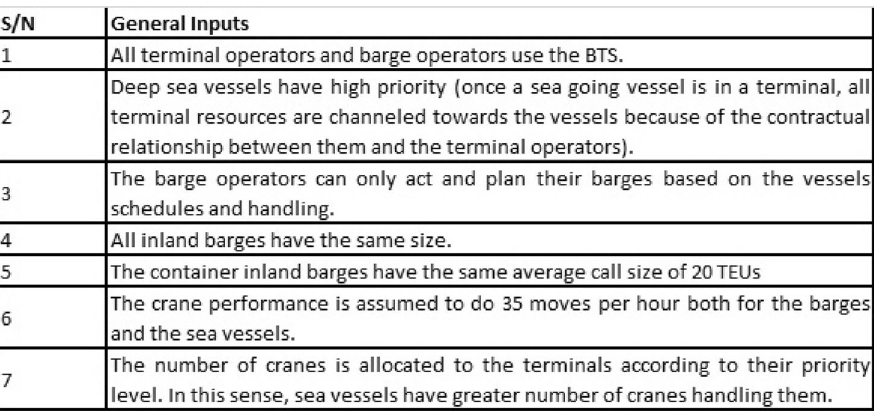
Table 2 Overview of the different inputs in the ABM